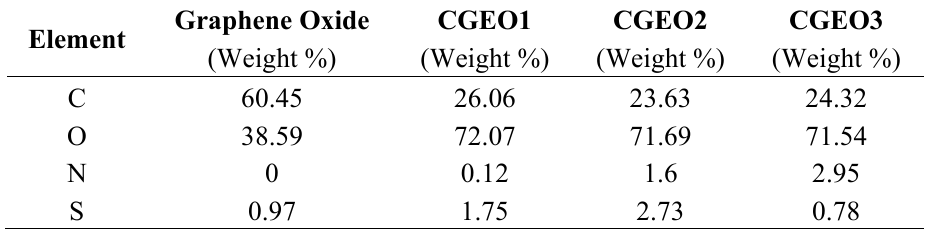
Table 2. Results of energy dispersive spectra (EDS) of graphene oxide,